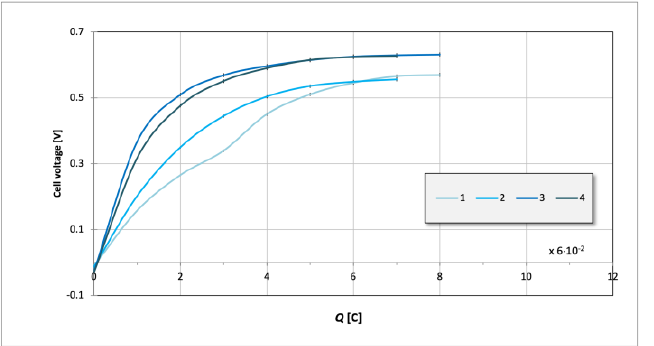
Figure 8. Influence of an anodic charge on the voltage of a half-cell with Cu-Ag (5% of Ag) electrode—influence on the catalytic activity of electrode (lines 1–4 corresponding with 1st, 2nd, 3rd, and 4th anodic charge). Table 2. Power and voltage (maximum value) obtained in ML-MFC (powered with PYWW). Cathode: Cu-Ag (foam form) oxidized for 1–8 h.